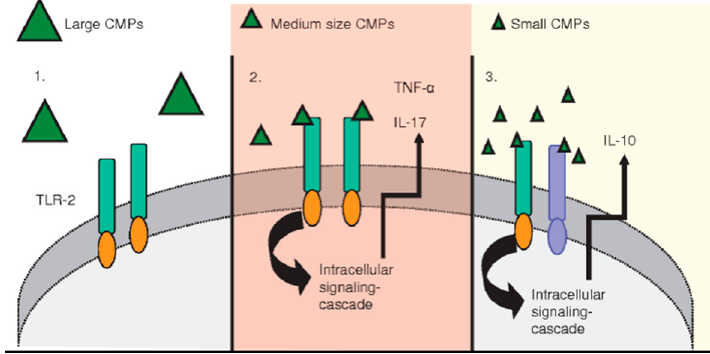
Figure 6. Pro-inflammatory and anti-inflammatory activity of chitin is a function of its dimension [61].